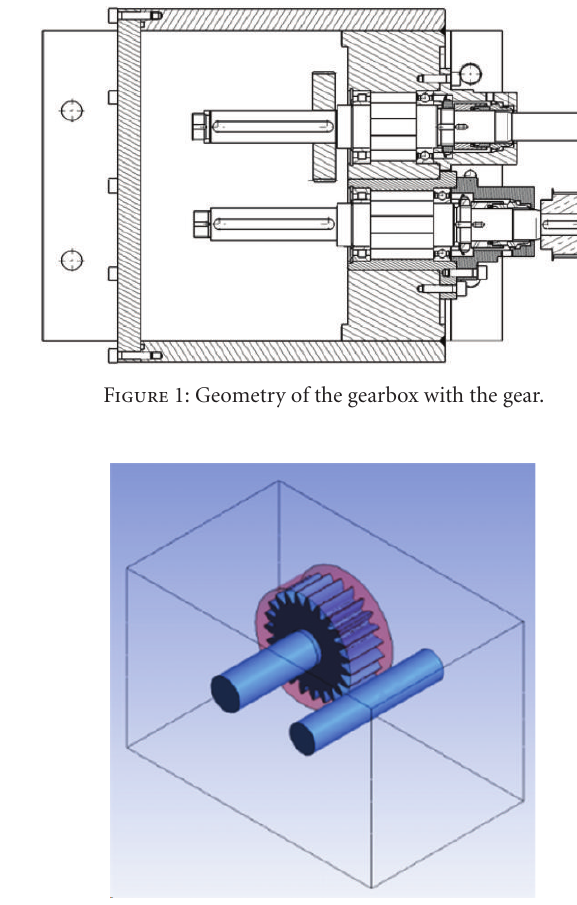
Figure 2: Geometry for the numerical model. Table 1: Oil properties of the used lubricants.